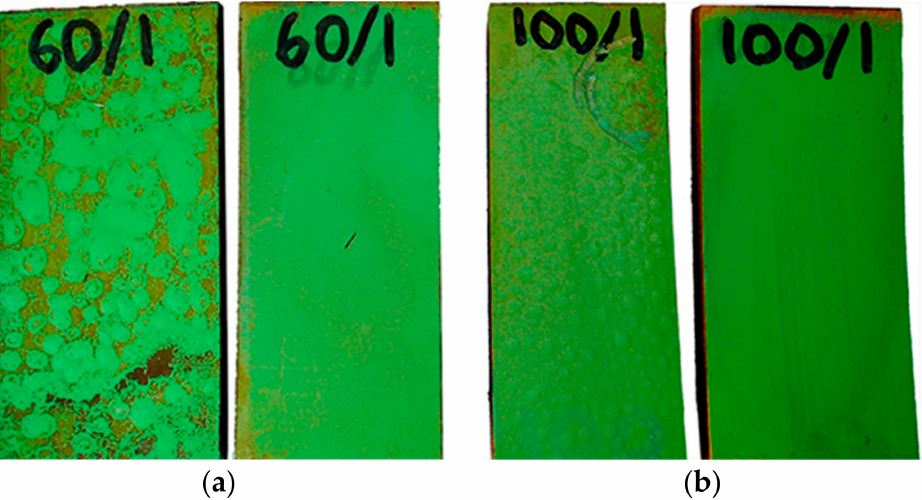
Figure 5. Samples after autoclave decompression tests: ( a ) samples tested at a temperature +60 ◦ C; ( b ) samples tested at a temperature + 100 ◦ C.